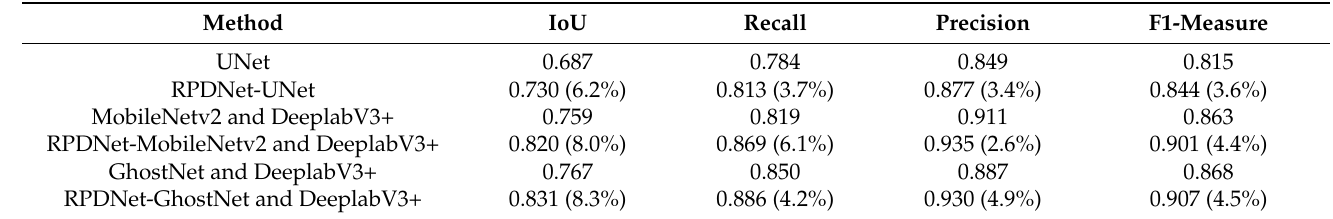
Table 5. Results of extended experiments with RPDNet. We record the percentage improvement in